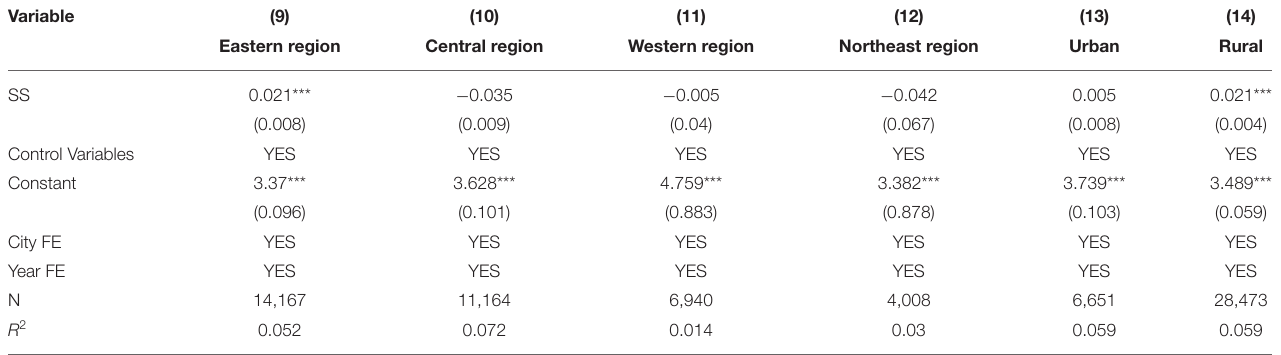
TABLE 7 | The regression results of the subgroup samples.